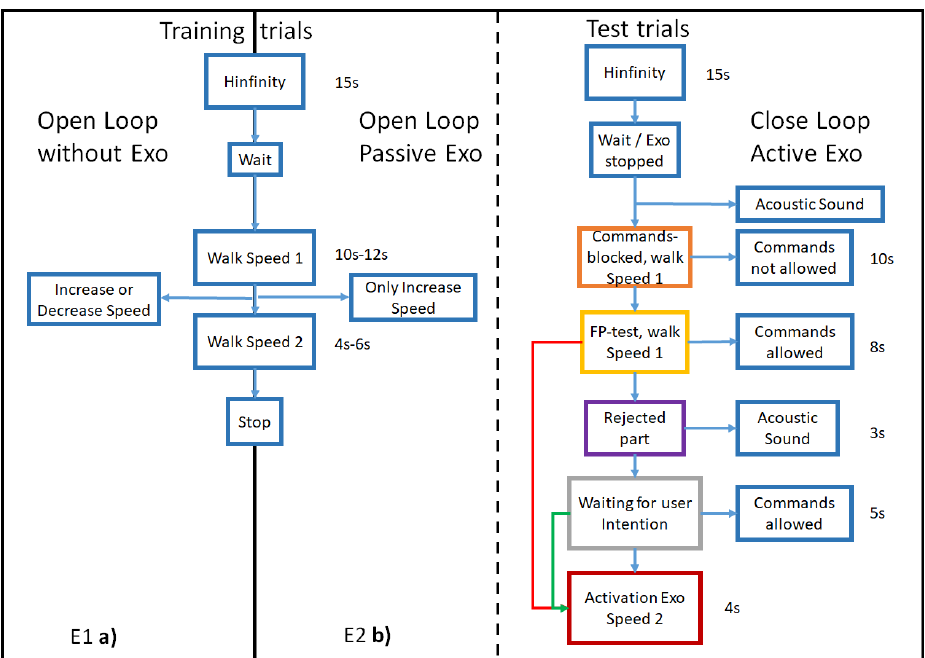
Figure 2. On the left of the image, the protocol times for training trials of experiments ( a ) E1 (without exoskeleton) and ( b ) E2 (with passive exoskeleton) are shown. Without assistance or any kind of feedback, the user brain signal is recorded. In test training trials (right side of the image), the exoskeleton is controlled in closed-loop active mode, changing the speed of the exoskeleton depending on the real-time decoding of the subject’s intention. This second protocol allows to validate the BMI obtaining the assessing metrics of its effectiveness executing the mental task in an unplanned